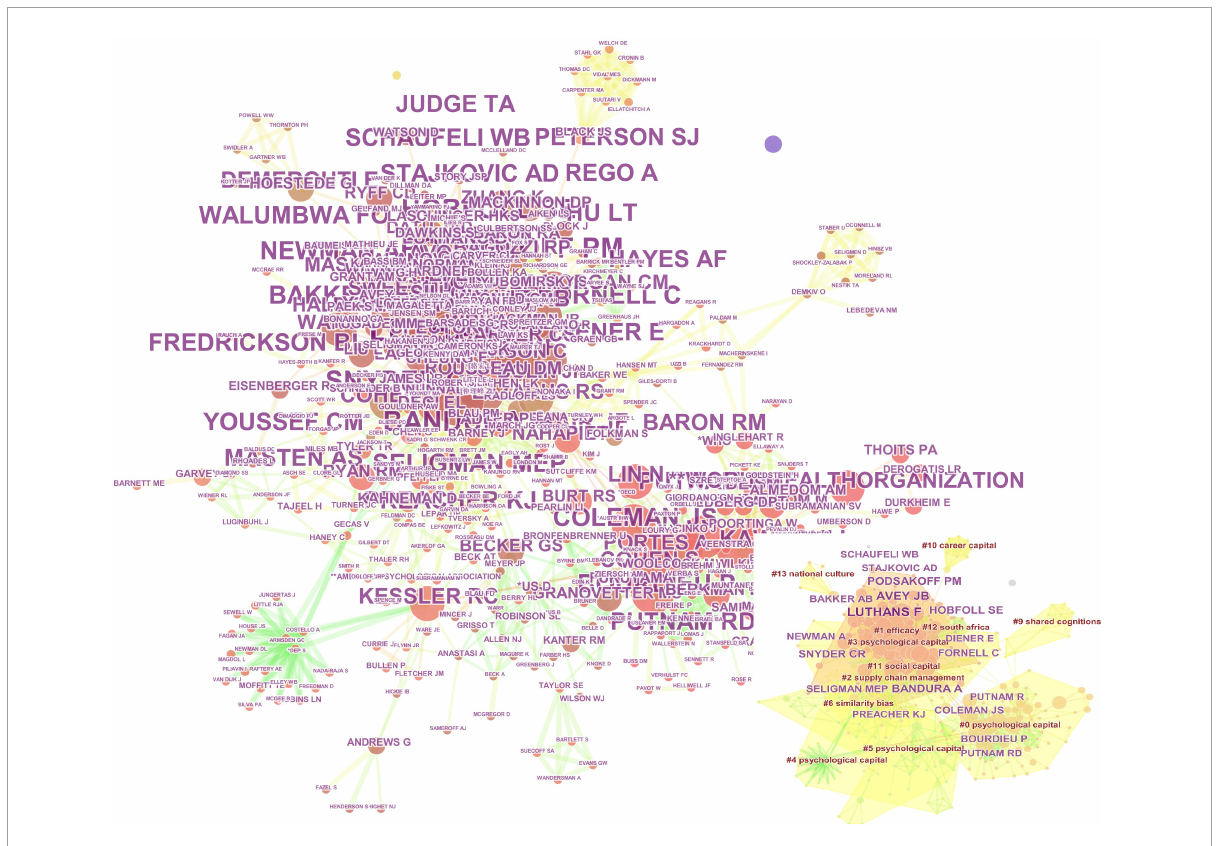
FIGURE4 Citation network and cluster of